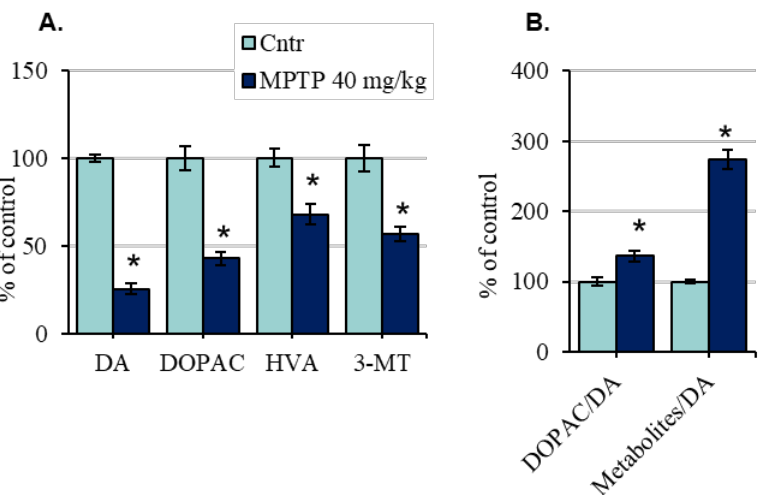
Figure 2. Dopamine (DA), 3,4-dihydroxyphenylacetic acid (DOPAC), homovanillic acid (HVA), and 3-methoxytyramine (3-MT) concentrations ( A ) and dopamine turnover: DOPAC/DA or Metabolites/DA((DOPAC + HVA + 3-MT)/DA) ( B ), presented as % of the control, in the striatum of mice 24 h after a single injection of 1-methyl-4-phenyl-1,2,3,6-tetrahydropyridine (MPTP) at a dose of 40 mg/kg) (“n” per group = 8). * p < 0.05, significant differences compared with the control, taken as 100% (the Student’s t- test). Data are presented as mean ± SEM. Cntr—the control group received 0.9% NaCl.